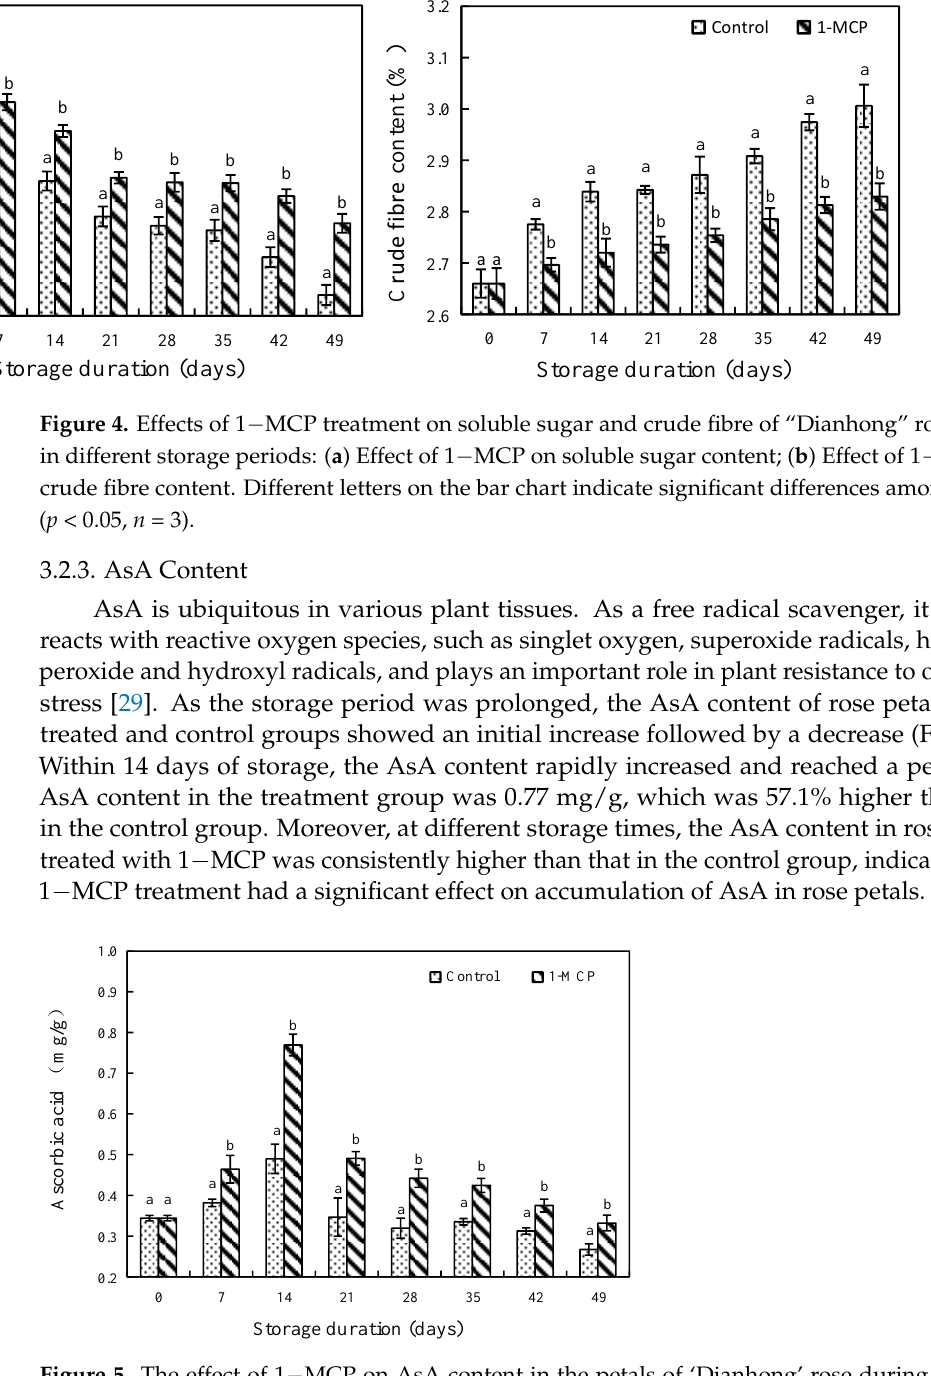
Figure 5. The effect of 1 − MCP on AsA content in the petals of ‘Dianhong’ rose during different storage periods. Different letters on the bar chart indicate significant differences among group ( p < 0.05, n = 3).